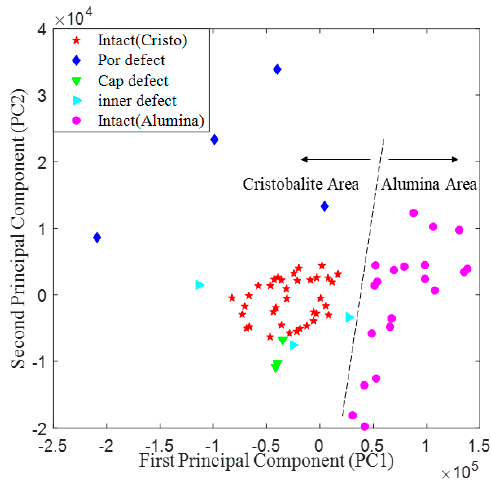
Figure 15. Two-dimensional plot using two eigenvectors extracted from frequency response of all